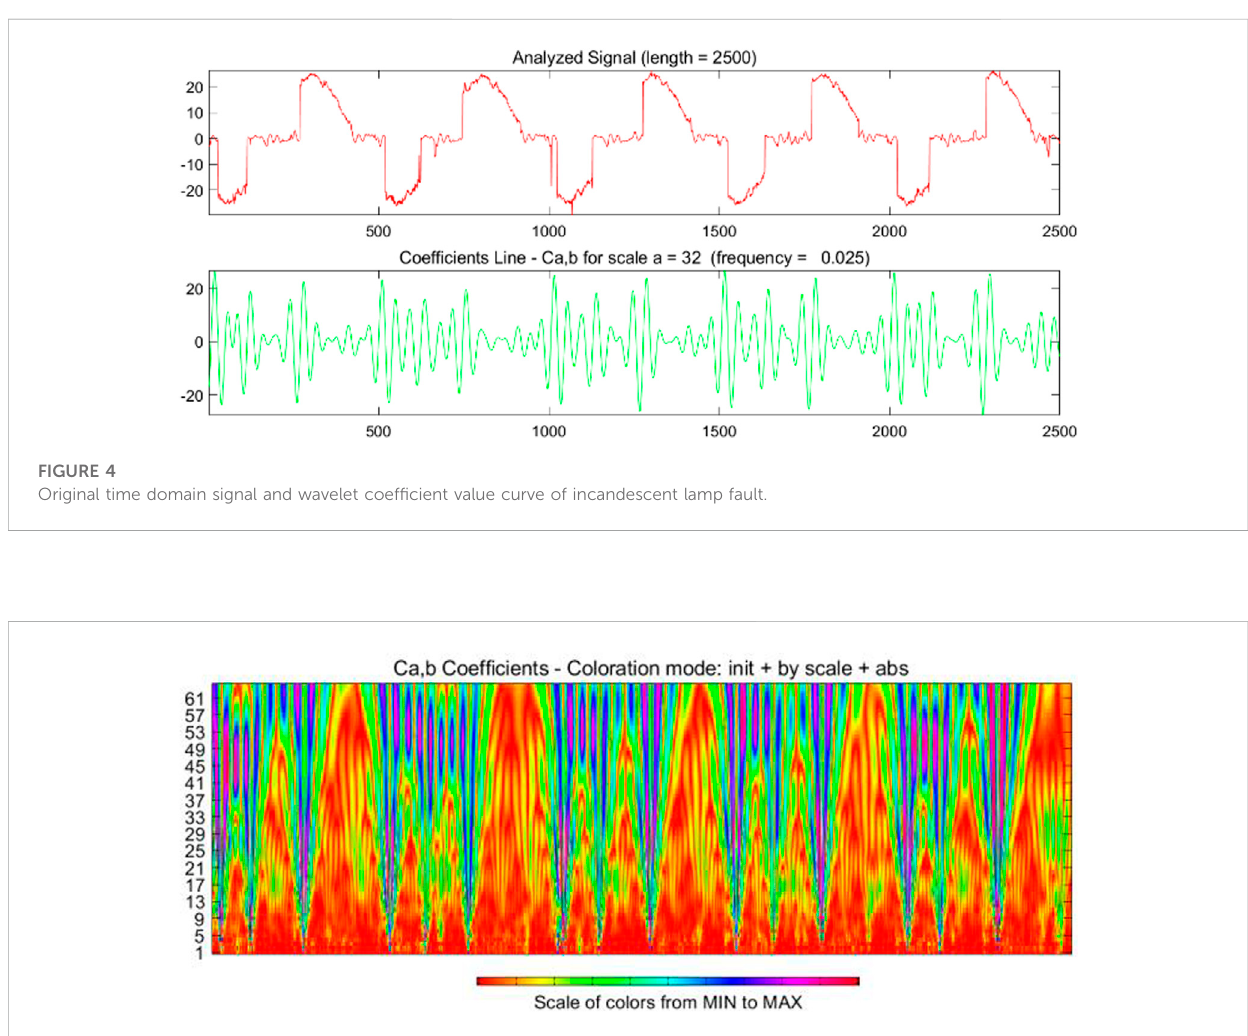
FIGURE 5 Depth map of phase space of continuous wavelet transform.